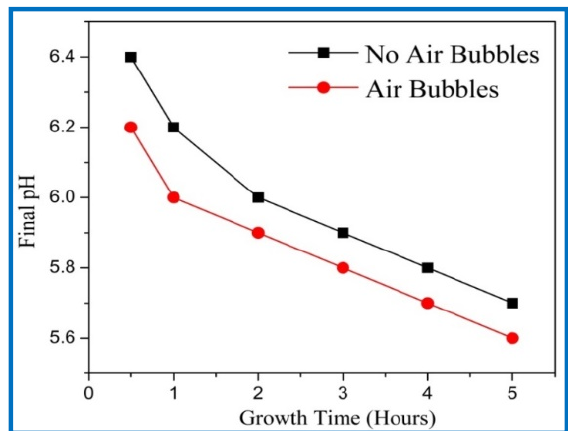
Figure 6. Effect of growth times on final pH value of growth’s solution when ZnO nanorods were fabricated, in the case of no air bubbles and in the case of air